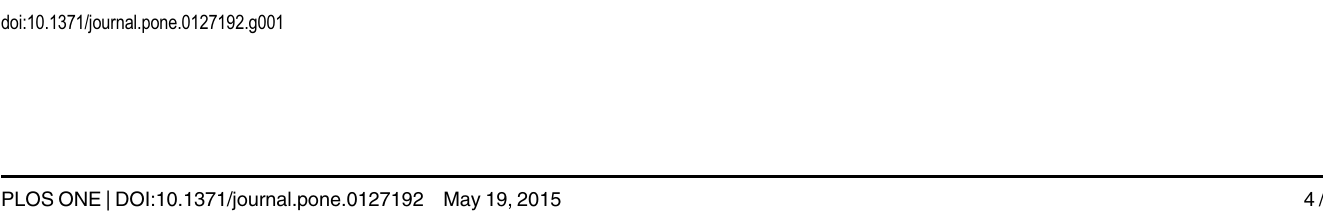
PLOS ONE | DOI:10.1371/journal.pone.0127192 May 19,